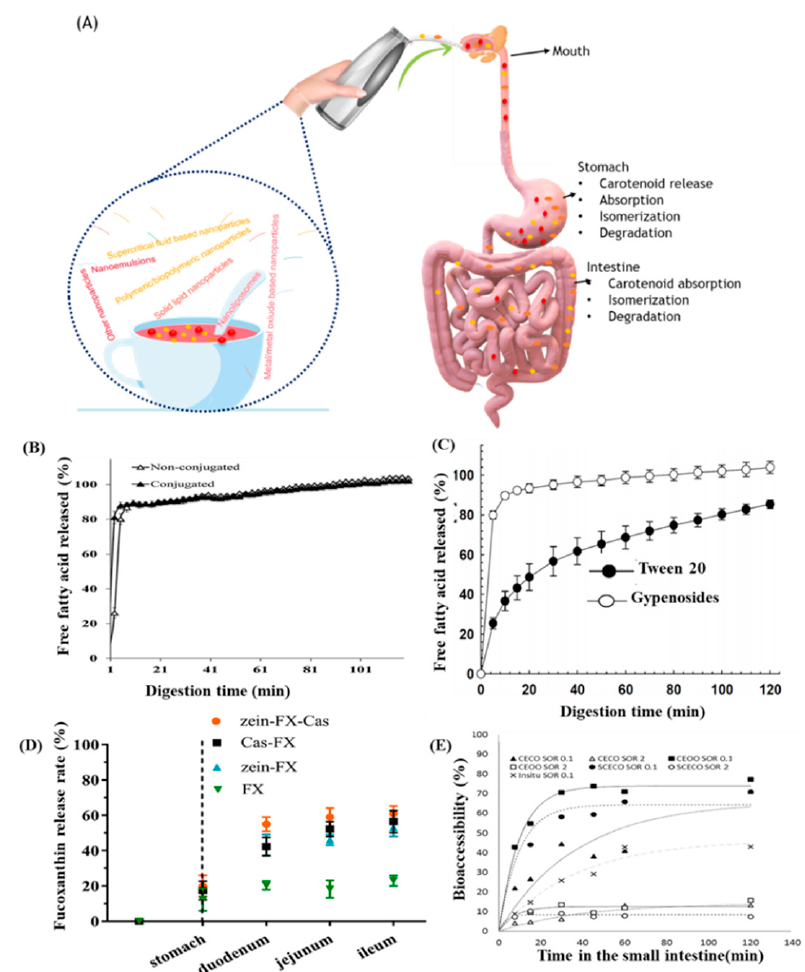
Figure 16. Selected in vitro digestion studies of nanoencapsulated carotenoids. A schematic on gastrointestinal absorption of nanoencapsulated carotenoids ( A ), free fatty acid release